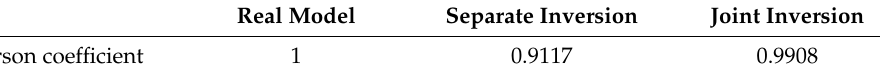
Table 9. Pearson correlation coefficients of inversion results. Figure 18. Slice of density (up) and magnetization (down) at y = 5000 m. ( a , d ) Real model; ( b , e ) Figure 19. Cross-gradient of inversion result. ( a ) Separate result; ( b ) joint result. separate result; ( c , f ) joint result. Table 8. RMSm of inversion results.